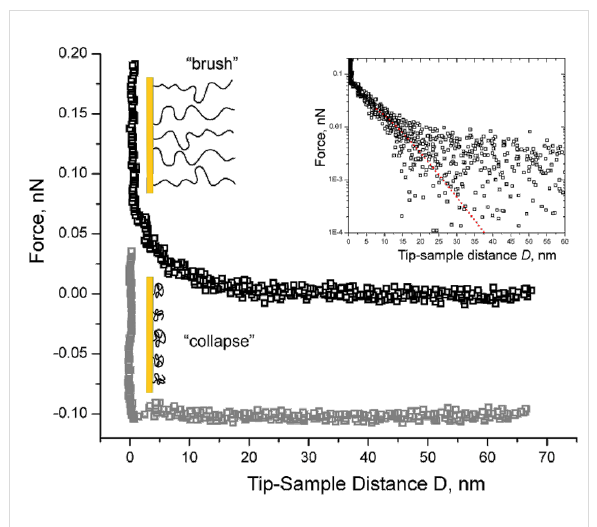
Figure 5: Representative force curves obtained by approaching the AFM tip to the Au surface grafted with 20 kDa mPEG–SH. The expo- nentially decaying long-range repulsive force in the upper curve indi- cates that the PEG chains are “brush-like” (black squares) in PBS. Inset: The corresponding fit using eq 3 (red line) gives fitted values of 27.4 ± 0.2 nm and 18.1 ± 0.1 nm for L and s , respectively. The data collected beyond a certain D is scattered being less than the minimum detectable force, which is given by the thermal noise of the AFM- cantilever: F min = ( k B T × k AFM ) 1/2 ≈ 5 pN. The weak repulsion at ~5 nm in the lower curve indicates that the PEG chains are no longer brush- like in 20% 2-propanol and have collapsed to form a layer that is ~5 nm thick (gray squares). The 0.1 nN offset distinguishes the two force curves as being from separate